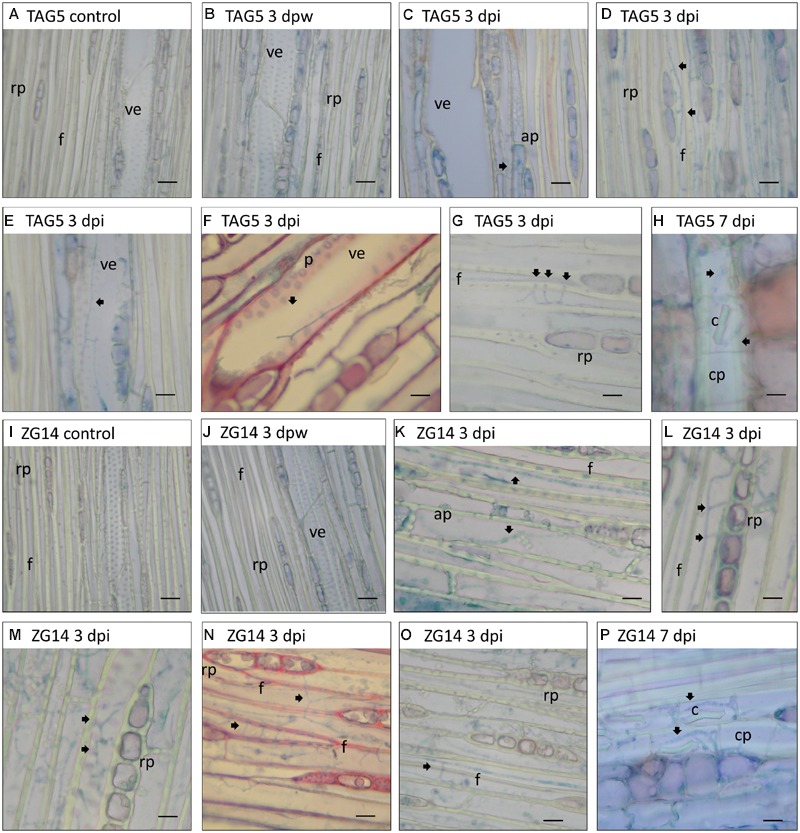
Light micrographs of the most frequent sites where C. austroafricana was observed within inoculated TAG5 and ZG14 plants. All sections were stained with lactophenol blue except (F,N), which were stained with safranin/fast green. (A–H) TAG5. (I–P) ZG14. Arrows indicate hyphae. dpw: days post-wounding; dpi: days post-inoculation; rp: xylem ray parenchyma; f: xylem fiber; ve: xylem vessel element; ap: axial xylem parenchyma; p: cell wall pits; cp: phloem crystalliferous parenchyma; c: crystal. Scale bars: 10 μm.